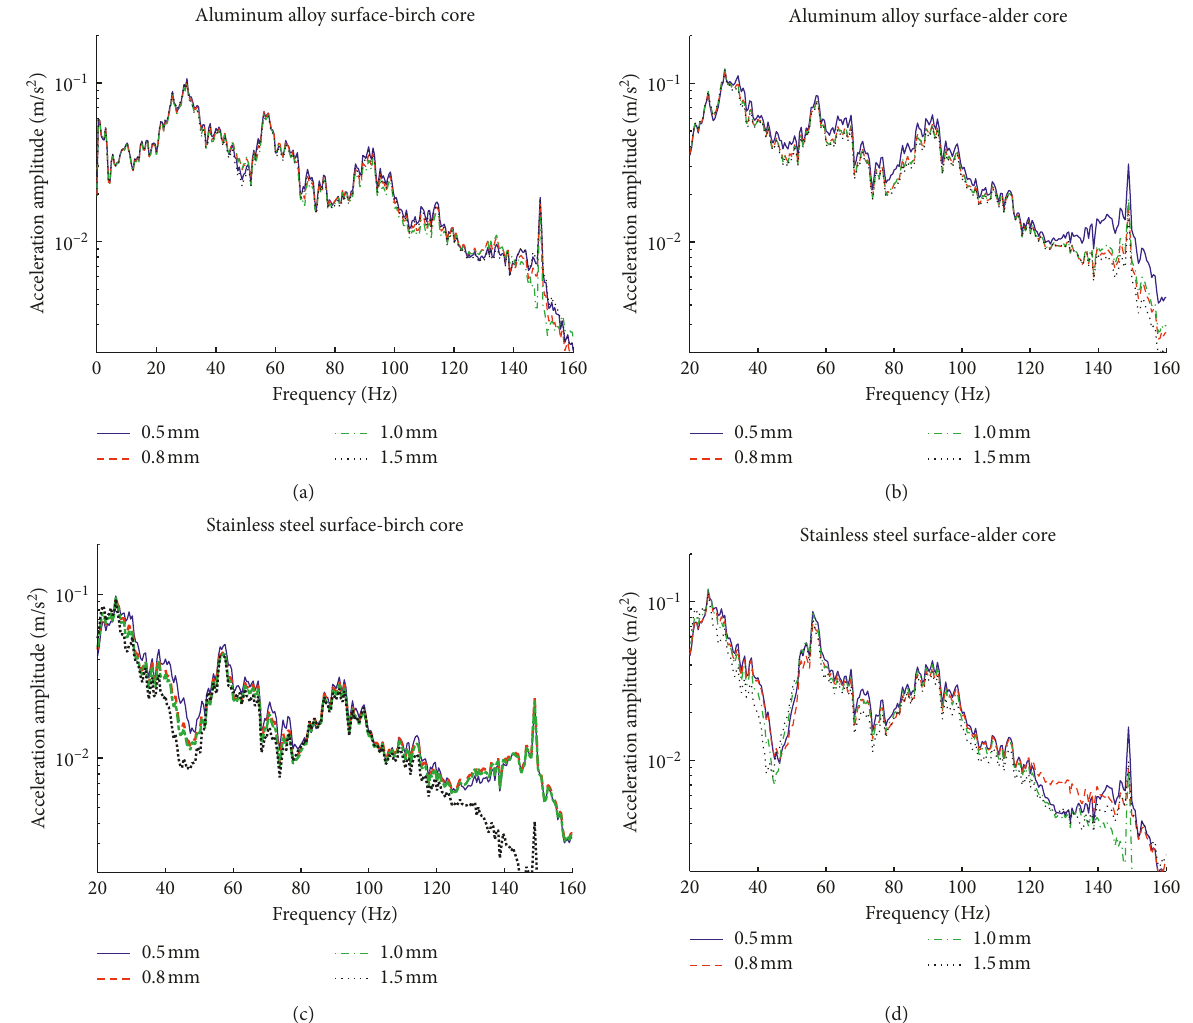
Figure 13: Time domain results of the vibration acceleration response. (a) Aluminum alloy with the birch core material. (b) Aluminum alloy with the alder core material. (c) Stainless steel with the birch core material. (d) Stainless steel with the alder core